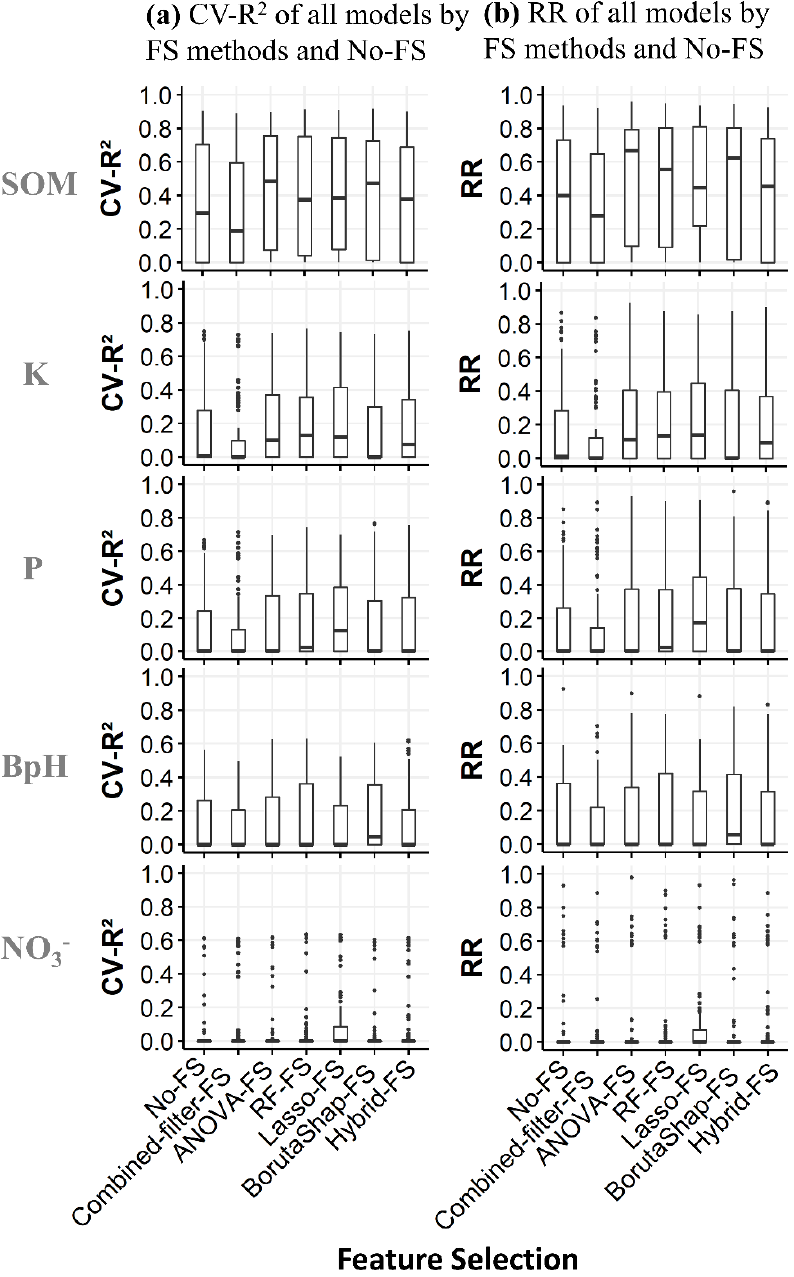
Figure 4. Comparisons of performance for models produced from the different FS treatments, evaluated by ( a ) CV-R 2 and ( b ) RR. Except for Combined-filter-FS, FS methods consistently outperformed the No-FS treatment. For the most part, evaluation of models by RR followed similar patterns to those of CV-R 2 , which suggests the higher CV-R 2 may also tend to have smaller differences between the goodness of fit R 2 and CV-R 2 .